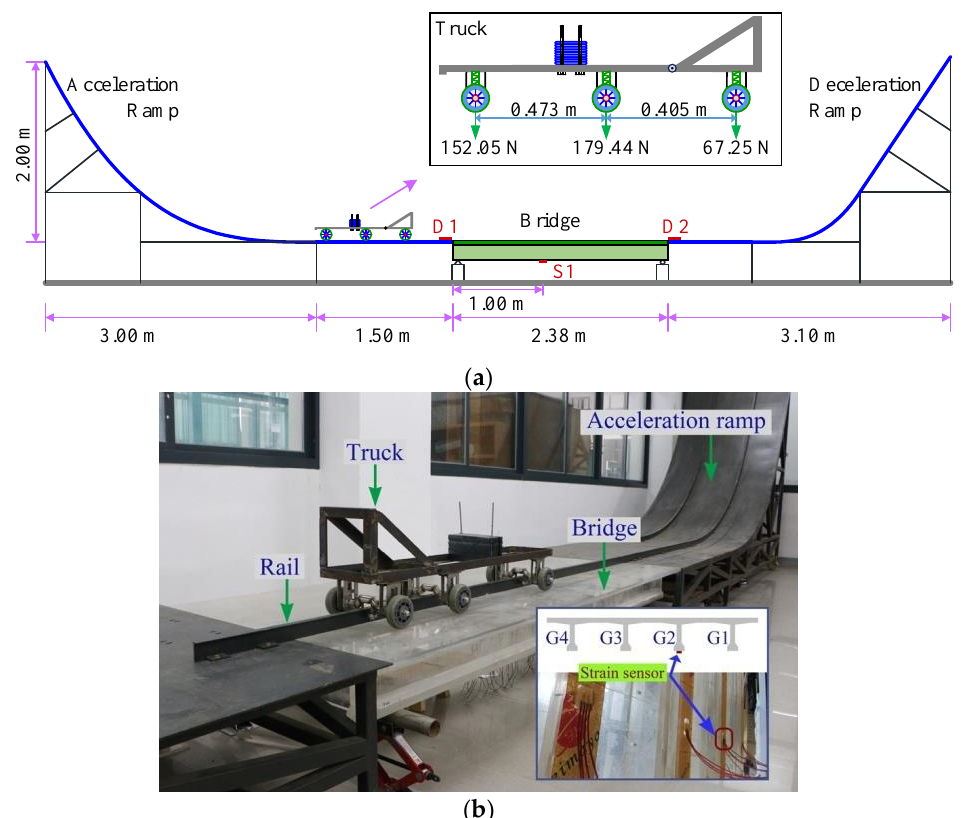
Figure 13. Test platform and truck model: ( a ) schematic illustration and ( b ) laboratory photo.